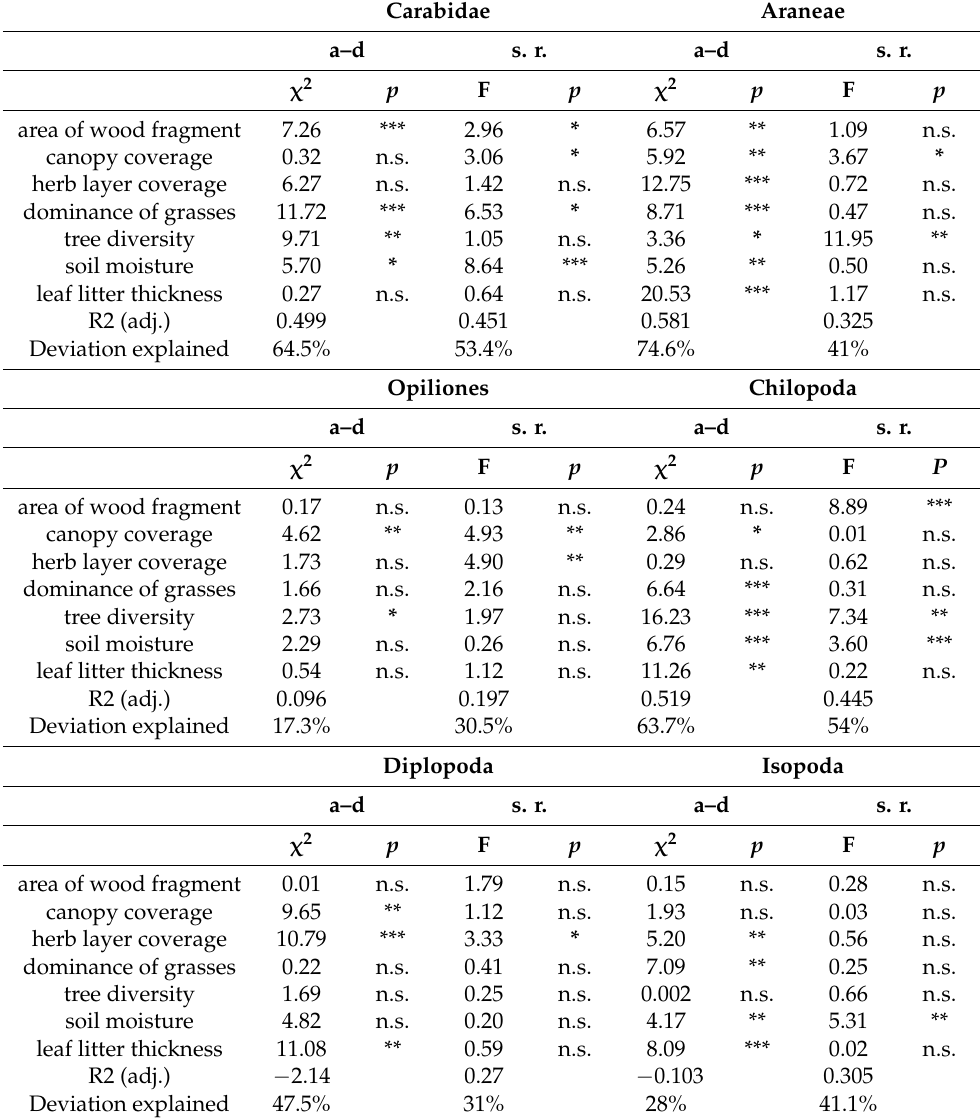
Table 1. The complex effects of measured environmental factors on activity-density (a–d) and species richness (s. r.) of invertebrate taxa. The resulting figures were obtained using GAM models. Codes for taxa indicate the degree of statistical significance: ‘***’ denotes p < 0.001, ‘**’ denotes p < 0.01, ‘ * ’ denotes p < 0.05, and ‘n.s.‘ denotes not